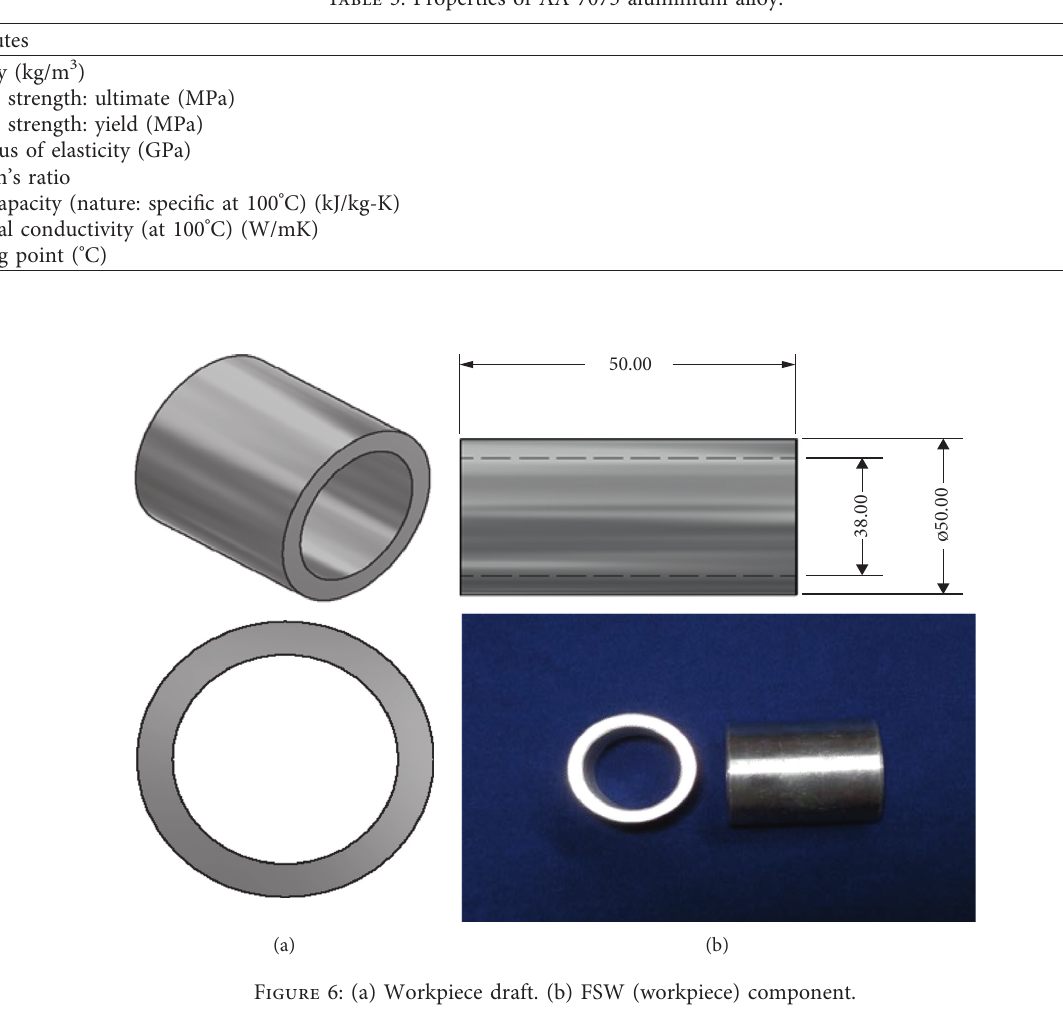
Table 3: Properties of AA 7075 aluminium alloy.